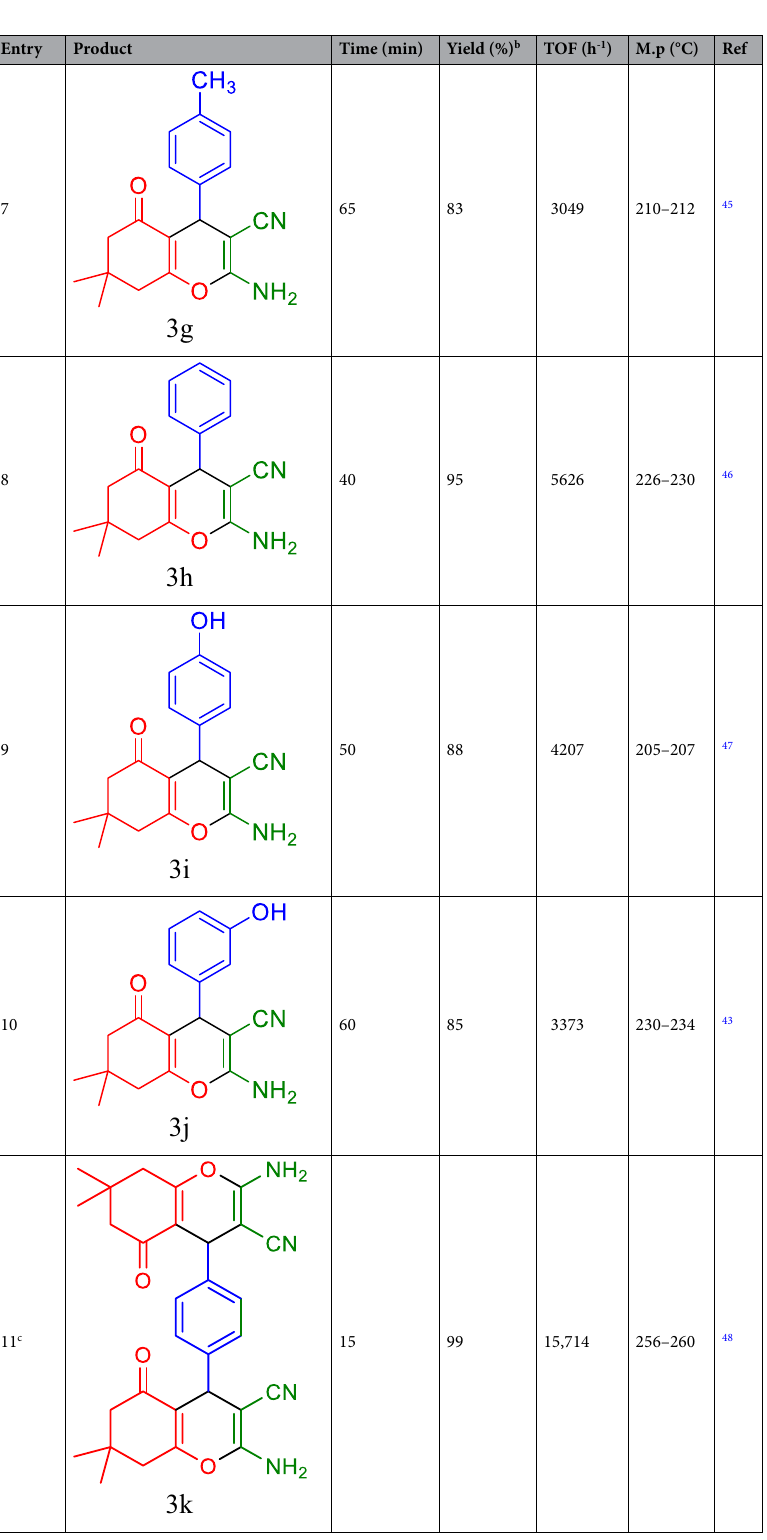
Table 8. One-pot synthesis of tetrahydrobenzo[b]pyran with aldehyde, malononitrile and dimedone catalyzed by HMS/Pr-PTSC-Cu a . a Reaction conditions: aldehyde (1 mmol), malononitrile (1 mmol),